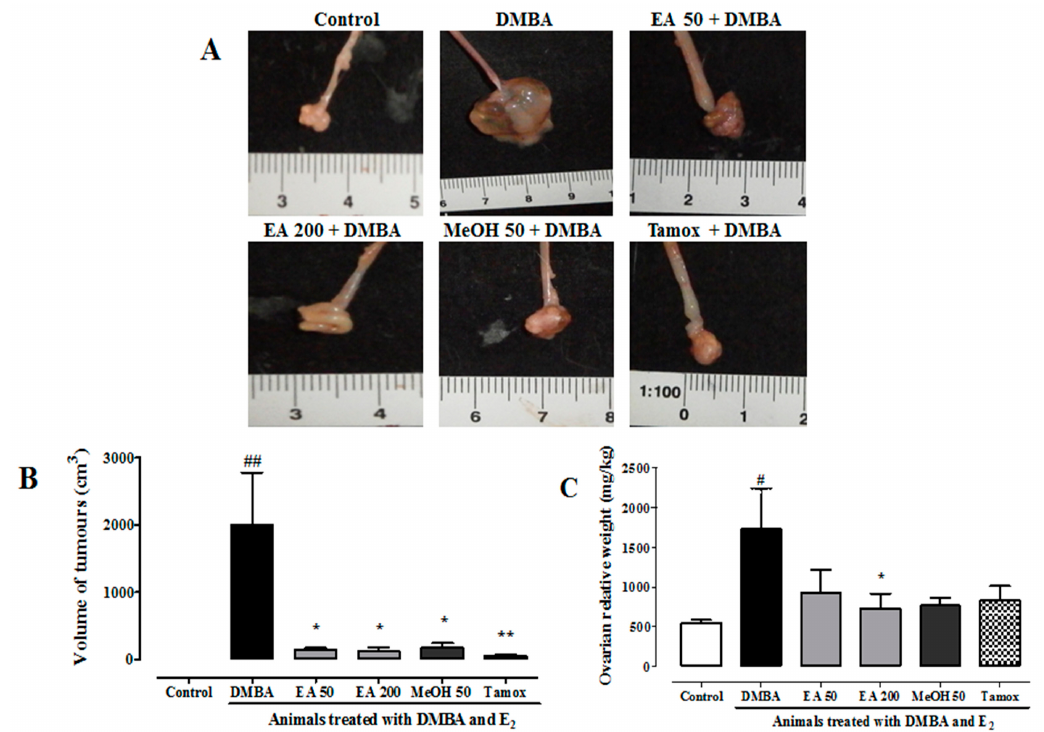
Figure 10. Effects of F. umbellata extracts on tumor parameters: ovarian tumors ( A ); volume of 1 tumors ( B ); and ovarian relative weight ( C ) after 20 weeks of treatment. Control, Normal control treated with 2% ethanol; DMBA, DMBA control treated with 2% ethanol; EA + DMBA, Animals treated with the F. umbellata aqueous extract at the doses of 50 and 200 mg/kg. MeOH + DMBA, Animals treated with the F. umbellata methanol extract at the dose of 50 mg/kg. TAM + DMBA, Animals treated with tamoxifen (3.3 mg/kg). All groups excepting the normal control group (NOR) received an intragastric dose of DMBA at the dose of 50 mg/kg followed by a 10-day subcutaneous administration of 17 β -estradiol (5 mg/kg). Data are represented as mean ± SEM ( n = 10). # p < 0.05 and ## p < 0.01 as compared to normal control. * p < 0.05 and ** p < 0.01 as compared to DMBA